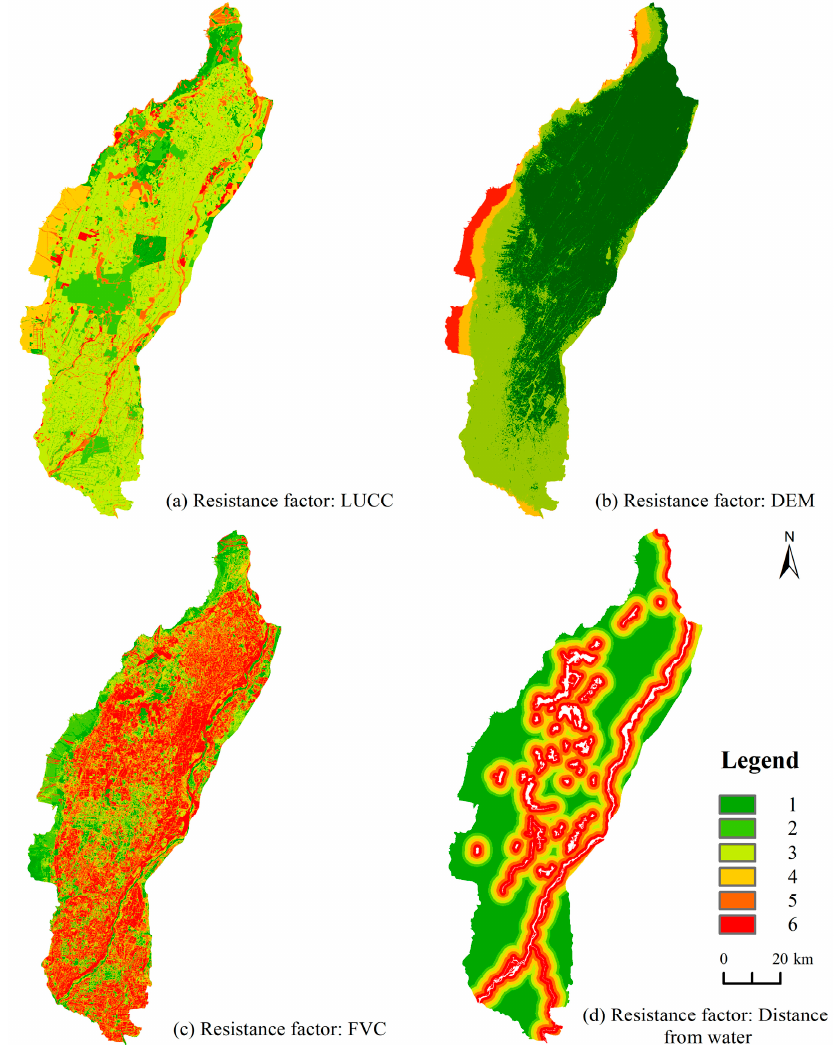
Figure 10. Four factors were used to construct the resistance surface: ( a ) Resistance surface of land-use type. ( b ) Resistance surface of digital elevation model. ( c ) Resistance surface of fractional vegetation cover. ( d ) Resistance surface of distance from water. The resistance value indicates the degree of resistance of the factor to the flow of the heat source, with a higher value indicating greater resistance, i.e., from low to high labeled as 1, 2, 3, 4, 5, and 6.